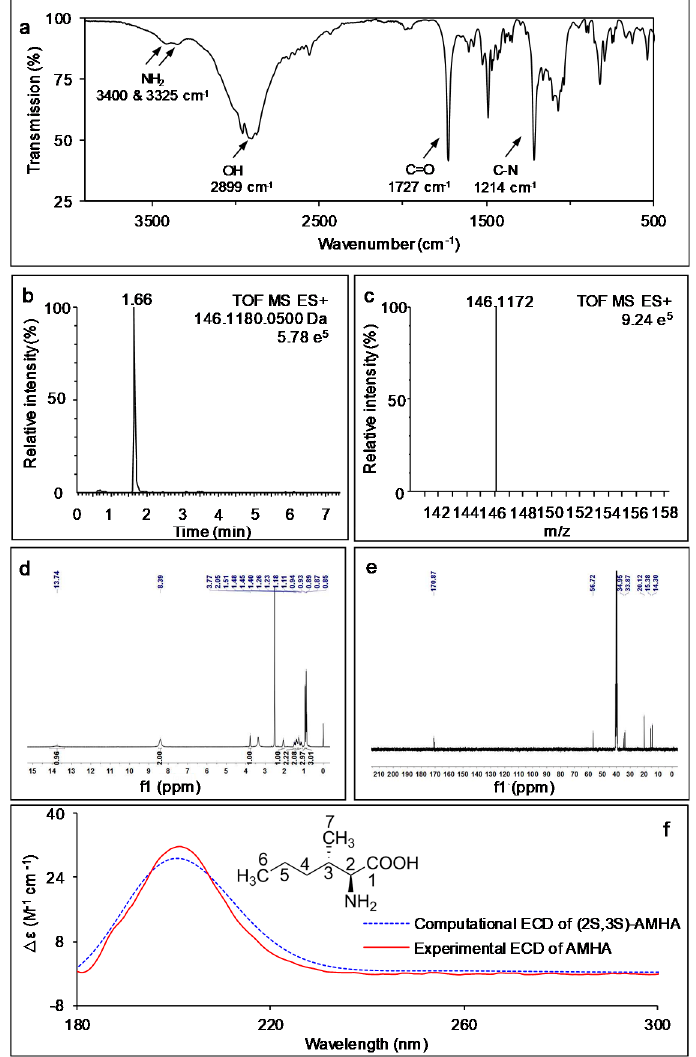
Figure 2. Spectra of naturally produced AMHA isolated from the mycelia of A. alternata . ( a ) IR spectrum. ( b ) UPLC ‒ MS chromatogram in positive ion mode. ( c ) Mass spectrum. ( d ) 1 H NMR spectrum (400 MHz, DMSO-d 6 ). ( e ) 13 C NMR spectrum (100 MHz, DMSO-d 6 ). Each spectrum is one of three independent biological replicates with similar results. ( f ) Comparison of experimental and computational ECD spectra of AMHA isolated from A. alternata .